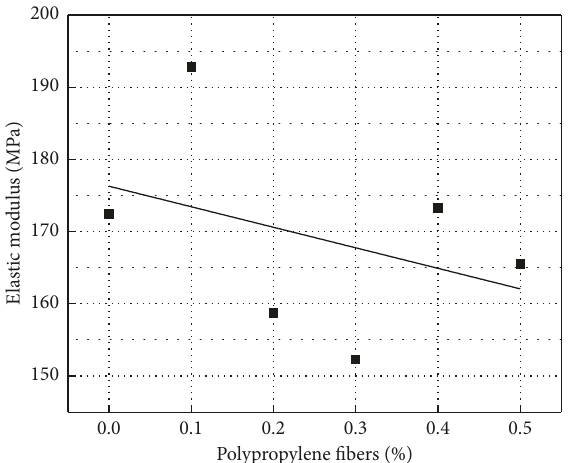
Figure 10: Elastic modulus diagram of soil-cement reinforced with different polypropylene fiber and 8% fly ash